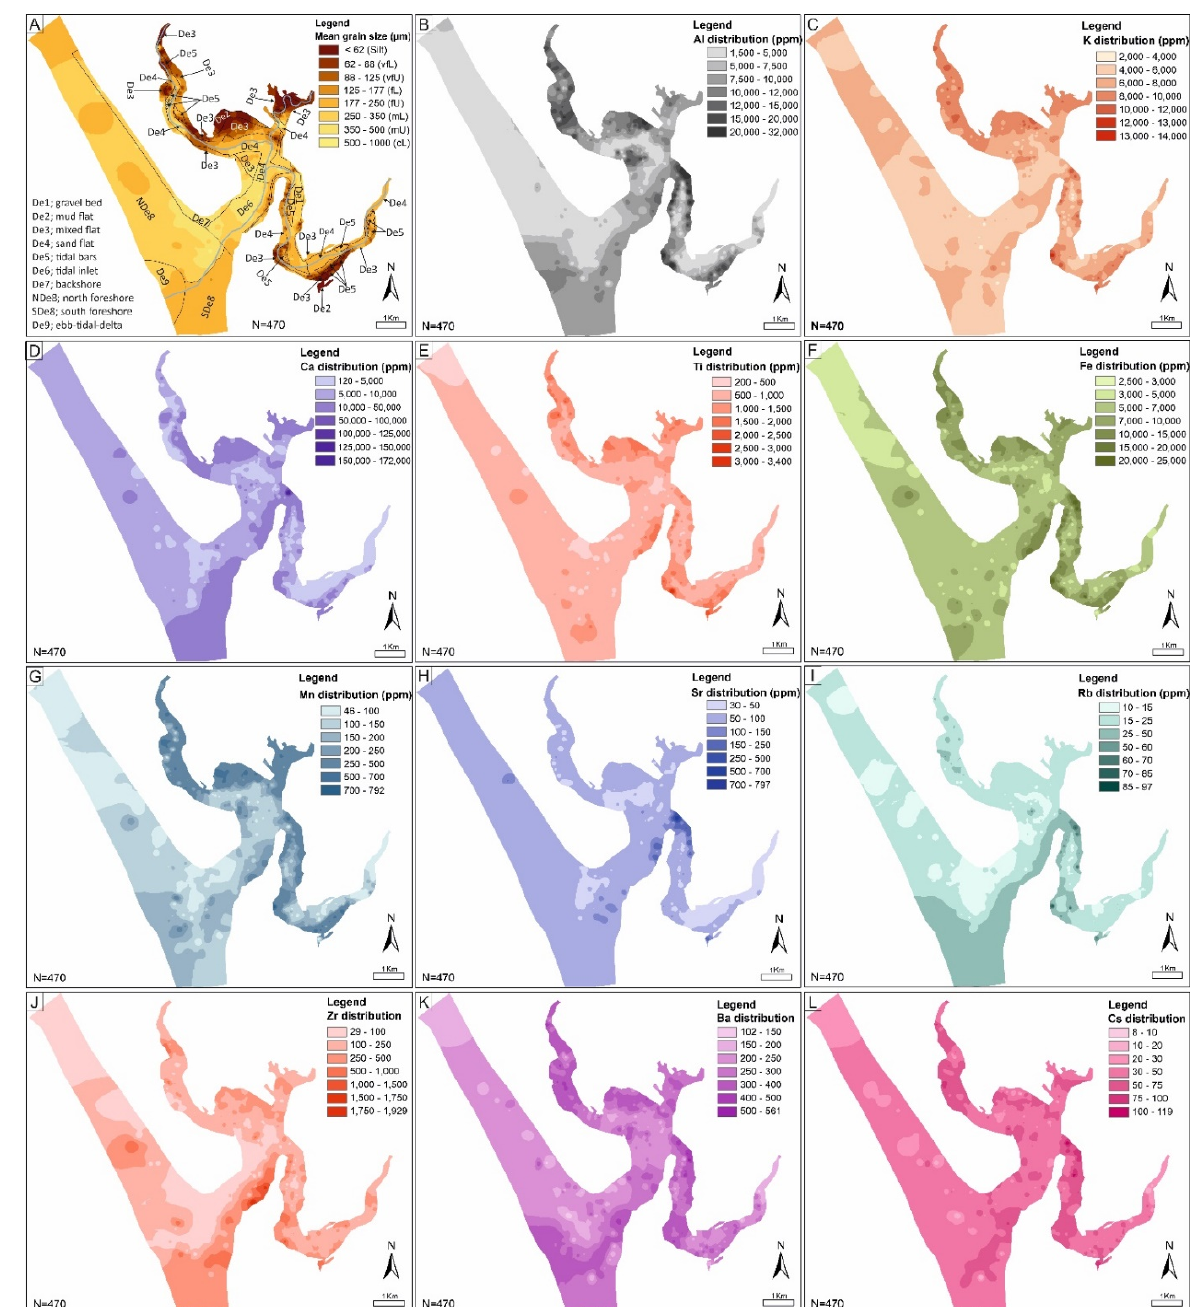
Figure 4. Spatial distribution of ( A ) grain size (mm), ( B ) aluminium (ppm, and for all other elements), ( C ) potassium, ( D ) calcium, ( E ) titanium, ( F ) iron, ( G ) manganese, ( H ) strontium, ( I ) rubidium, ( J ) zirconium, ( K ) barium, ( L ) and caesium within the Ravenglass Estuary. Note that mean grain size decreases towards the margins of the inner estuary and central basin and the grain size map ( A ) has had boundaries between sub-depositional environments from Figure 2 superimposed. The similarities in spatial distribution between Al and K with finer grain size, show potential control of mud on the distribution of these elements. Aluminium, K, Fe, Ti and Mn have their highest concentration across the inner estuary, upper reaches of Irt arm and tidal bars. Grain size as well as concentrations of Al, Ca and Rb are higher in the southern foreshore than the northern foreshore. The elements distribution pattern vary greatly with some apparent links to sub-depositional environment and geographic